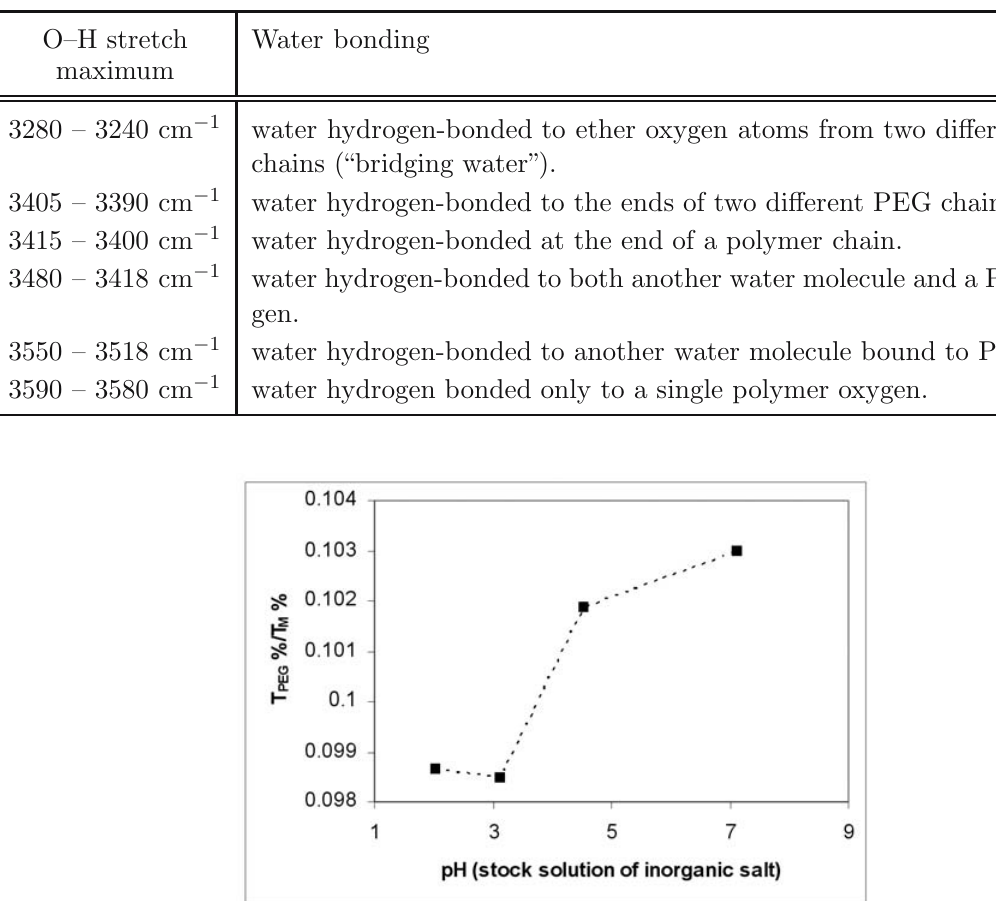
Table 2 Absorption maxima for water molecules bonded to PEG [14, 15].